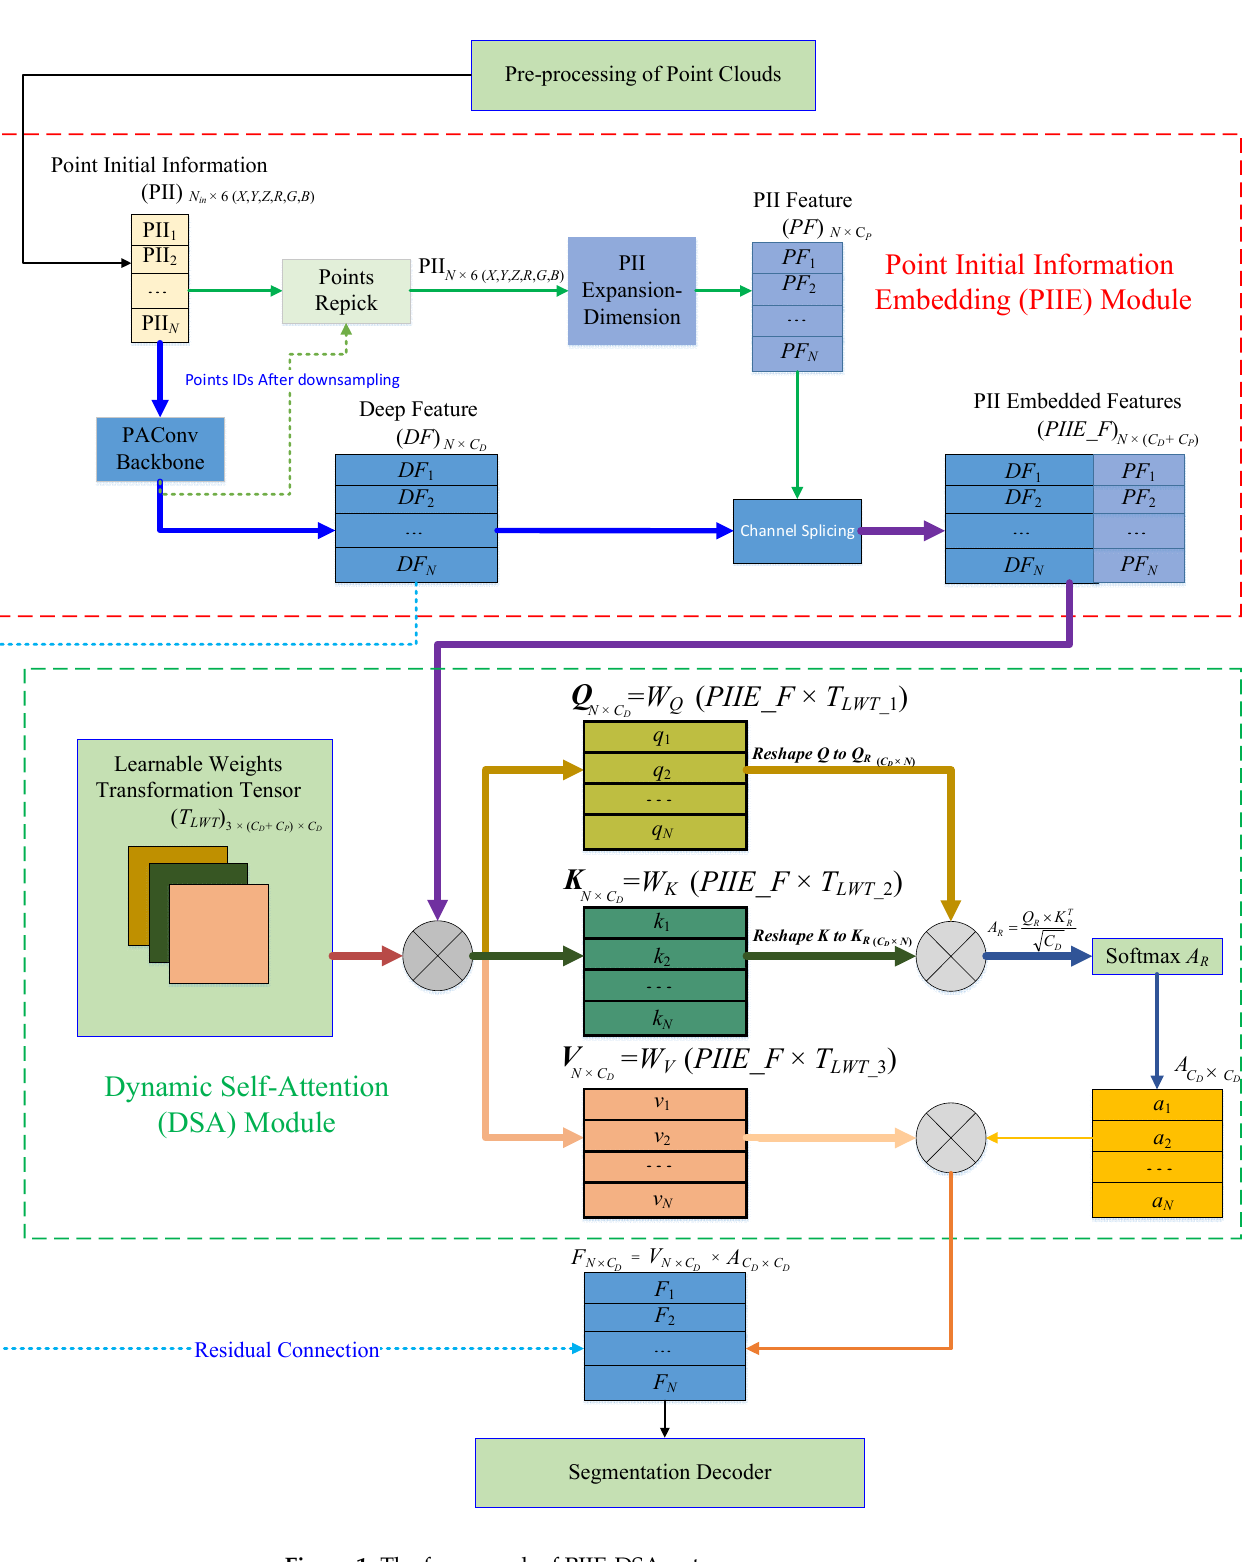
Figure 1. The framework of